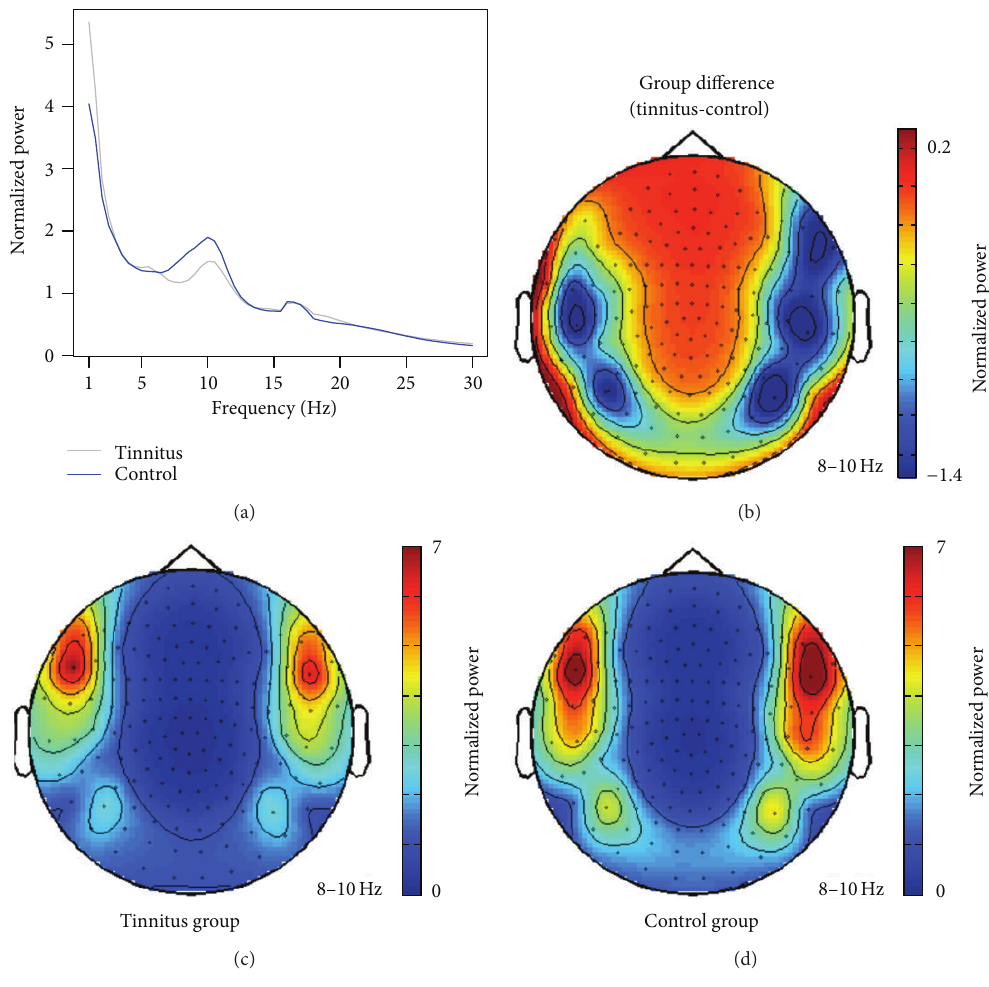
Figure1:Normalizedpower.(a)illustratesthenormalizedglobalpoweraveragedoverallsensors.(b)–(d)showthetopographicaldistribution ofthelow-frequencyalphapower(8–10 Hz)forthegroupdifference(tinnitusminuscontrol,(b)),thetinnitusgroup(c),andthecontrolgroup